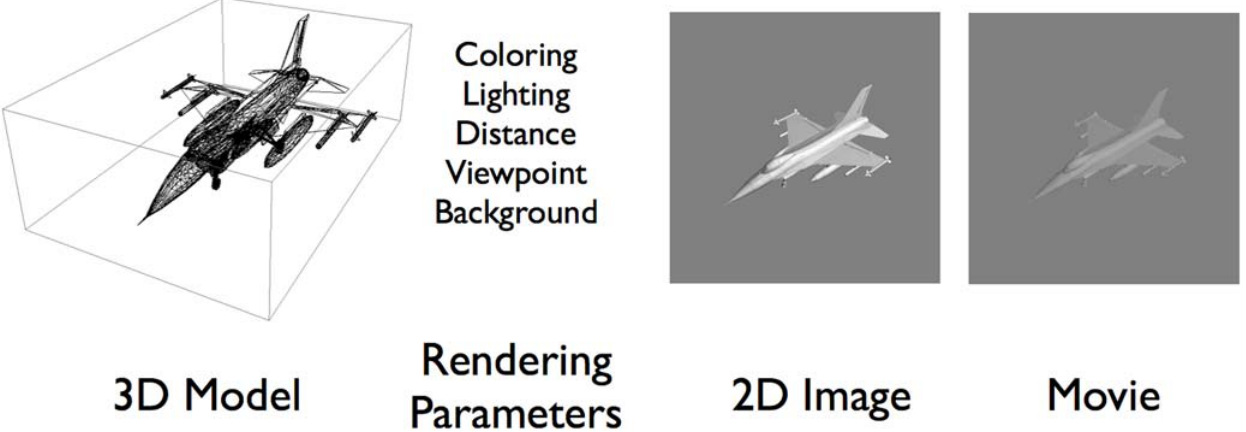
Figure 3. Rendering of aircraft stimuli from 3D graphic models. The first panel shows the 3D graphic model, depicted as a collection of triangular facets. The second panels shows the conditions that determine the rendering of the model. The third panel shows an example of a rendered 2D image. The third panel represents one frame from the stimulus movie created from the rendered 2D image. The corresponding movie is provided as supporting file Movie S1.